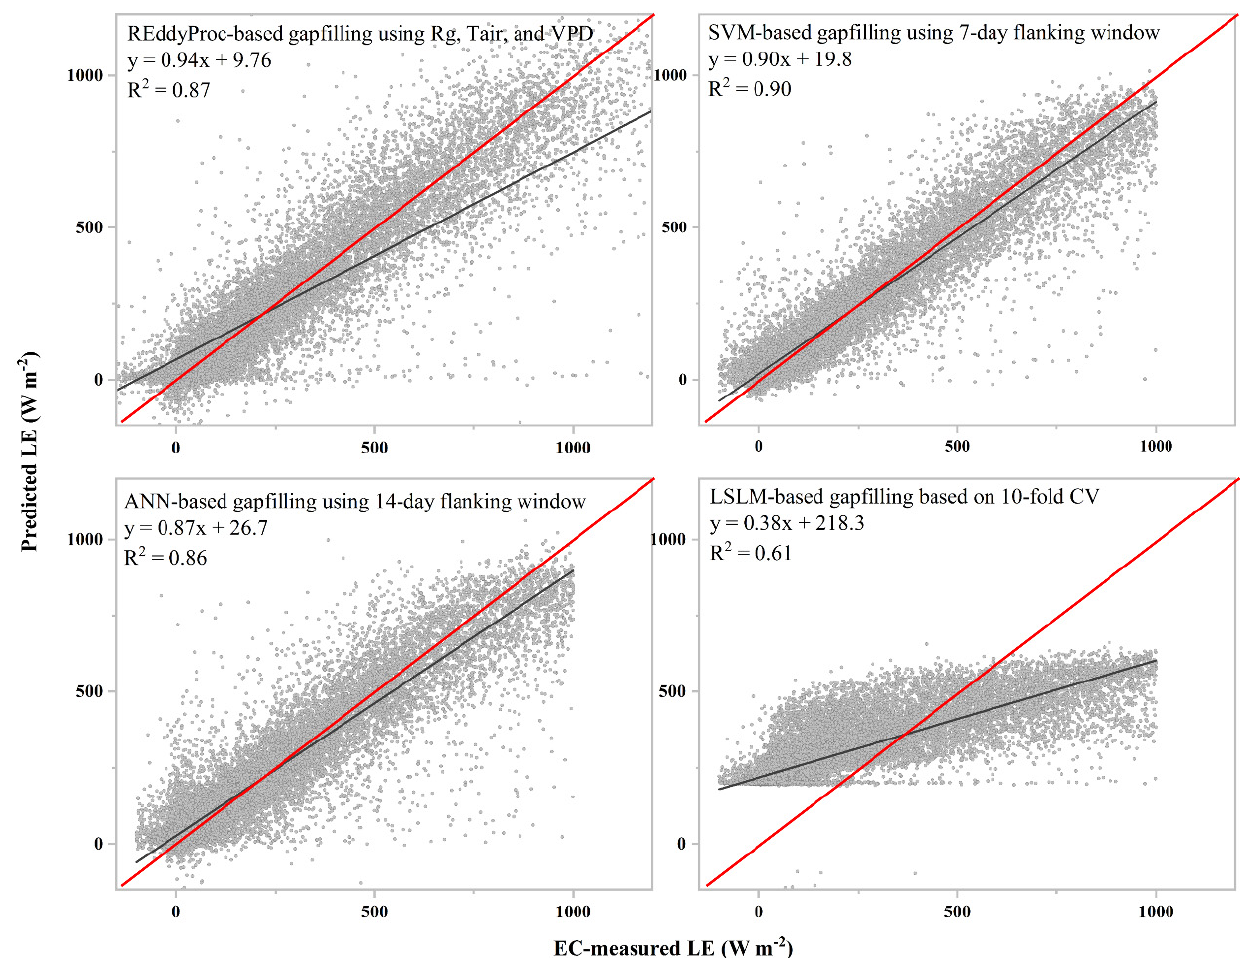
Figure 9. Benchmarking results of filling artificial gaps of the latent heat flux (LE) data based on the optimal prediction models and cross-validation settings. Regressions of predicted NEE by the REddyProc software using global radiation, ambient air temperature (Tair), and vapor pressure deficit (VAP, top-left); support vector machine (SVM, top-right) and artificial neural network (ANN, bottom-left) using 7- and 14-day window training data flanking each missing/testing value, respectively; and the least-square linear model (LSLM) based on a 10-fold cross validation (10-fold CV, bottom-right ); against the eddy-covariance (EC) measured LE values are presented. The red line indicated 1:1 perfect prediction line.